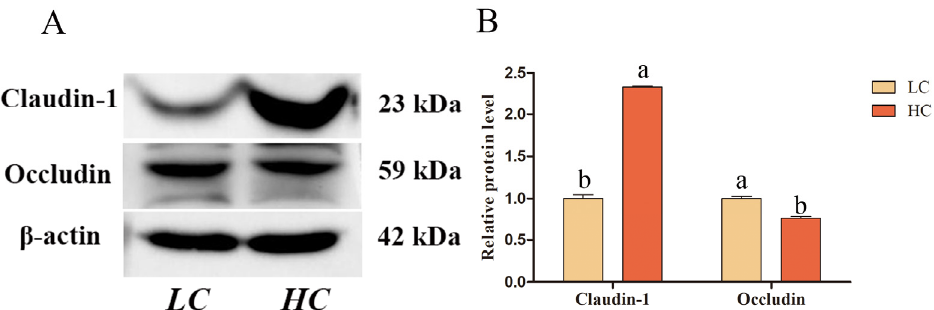
Figure 4. Relative protein expression levels of claudin-1 and occludin in the endometrial tissue of the HC and LC groups. ( A ) Western blotting. ( B ) Relative protein expression levels. Different lowercase letters indicate a significant difference at p < 0.05.